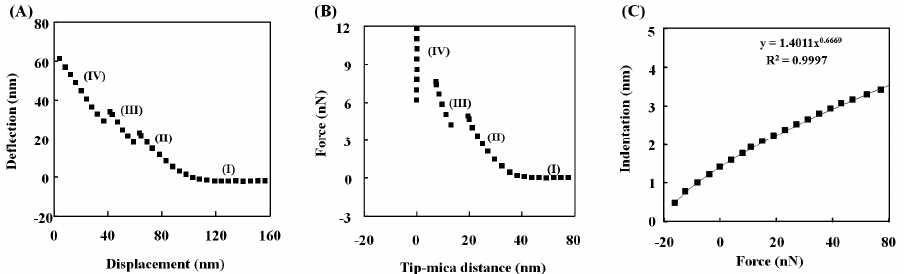
Figure 2. ( A ) Deflection with respect to displacement (z position) for the vesicle at 0% 3-hydroxybutyric acid; ( B ) force with respect to distance based on the data in ( A ); ( C ) indentation with respect to load force based on the region (II) data of ( A , B ).